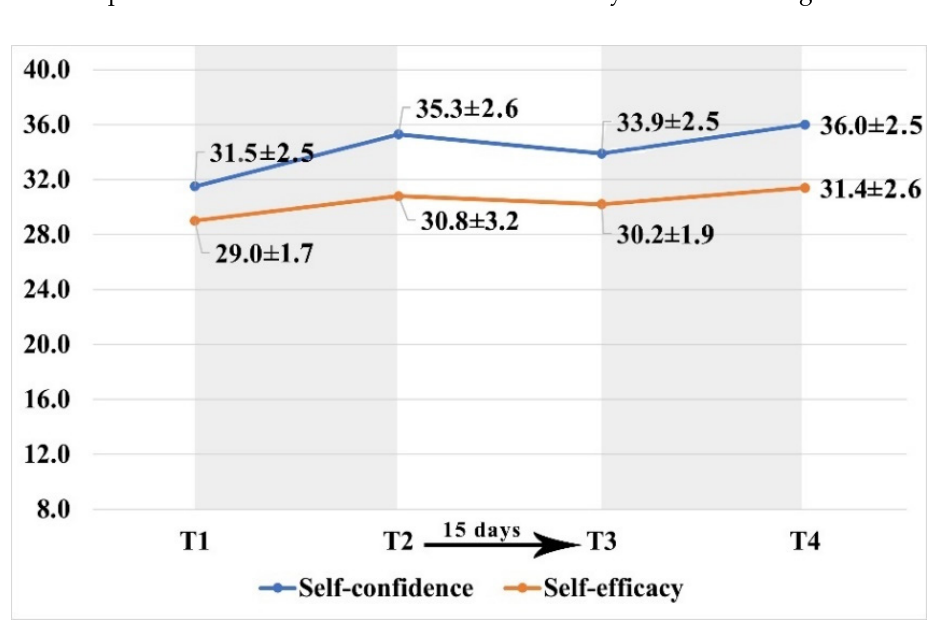
Figure 4. Performance during simulation sessions.